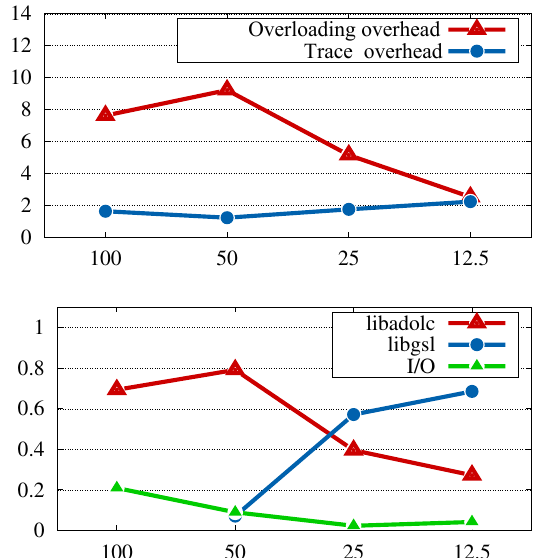
Figure 5. Test problem setup with the sequential GSL solver; plots over max mesh distance show overhead factors (upper frame) and approximate runtime portions of the model execution with adjoint computation (lower frame).